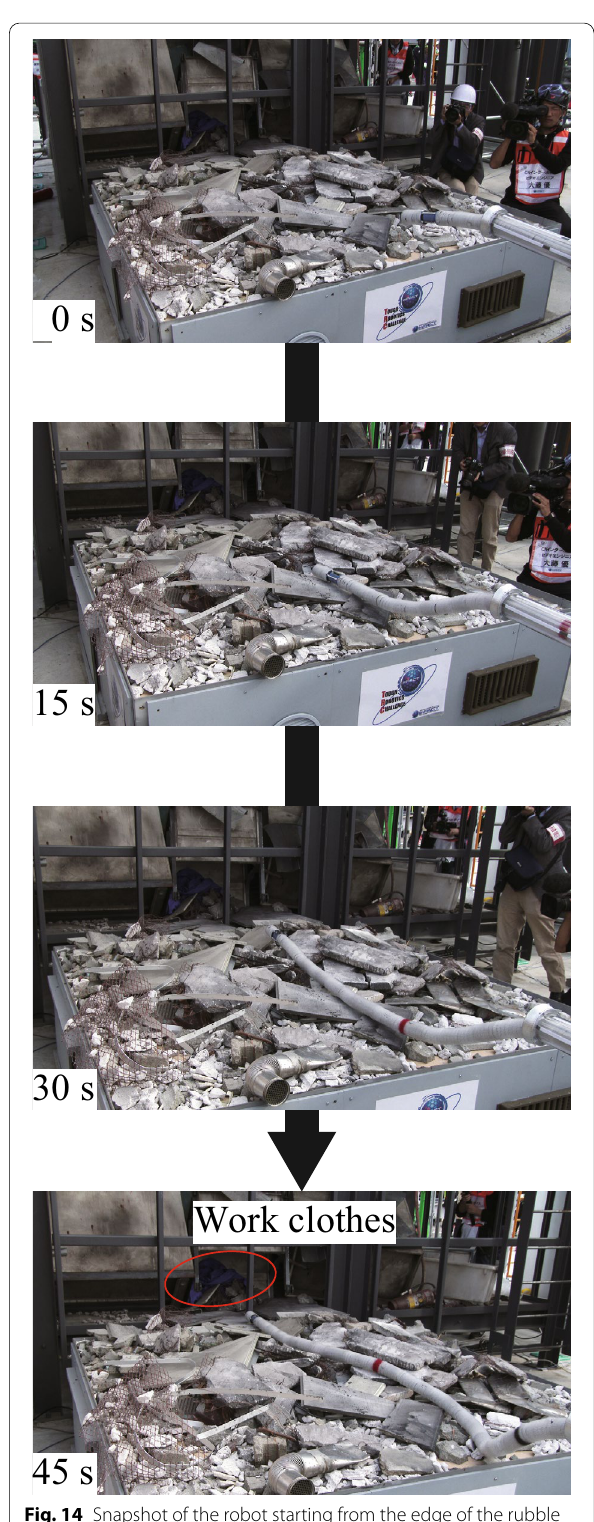
Fig. 14 Snapshot of the robot starting from the edge of the rubble and reaching the entrance of the